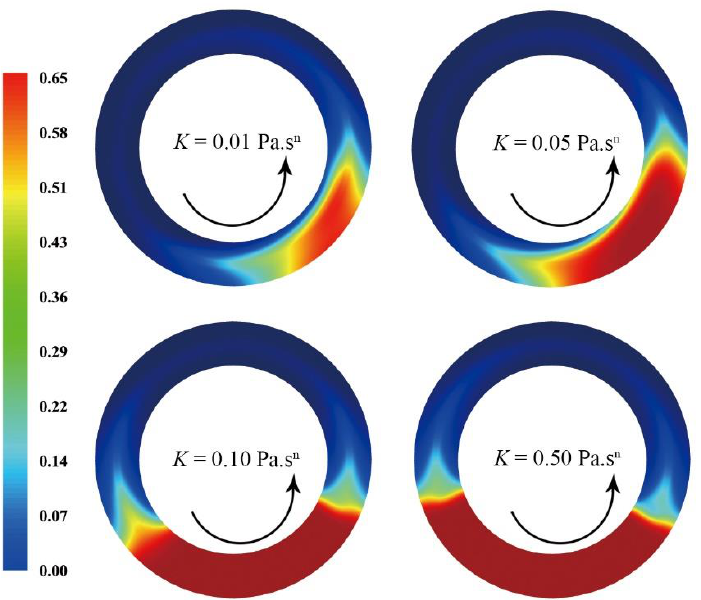
Figure 9. Annular cuttings concentration contour at different fluid consistency index conditions.